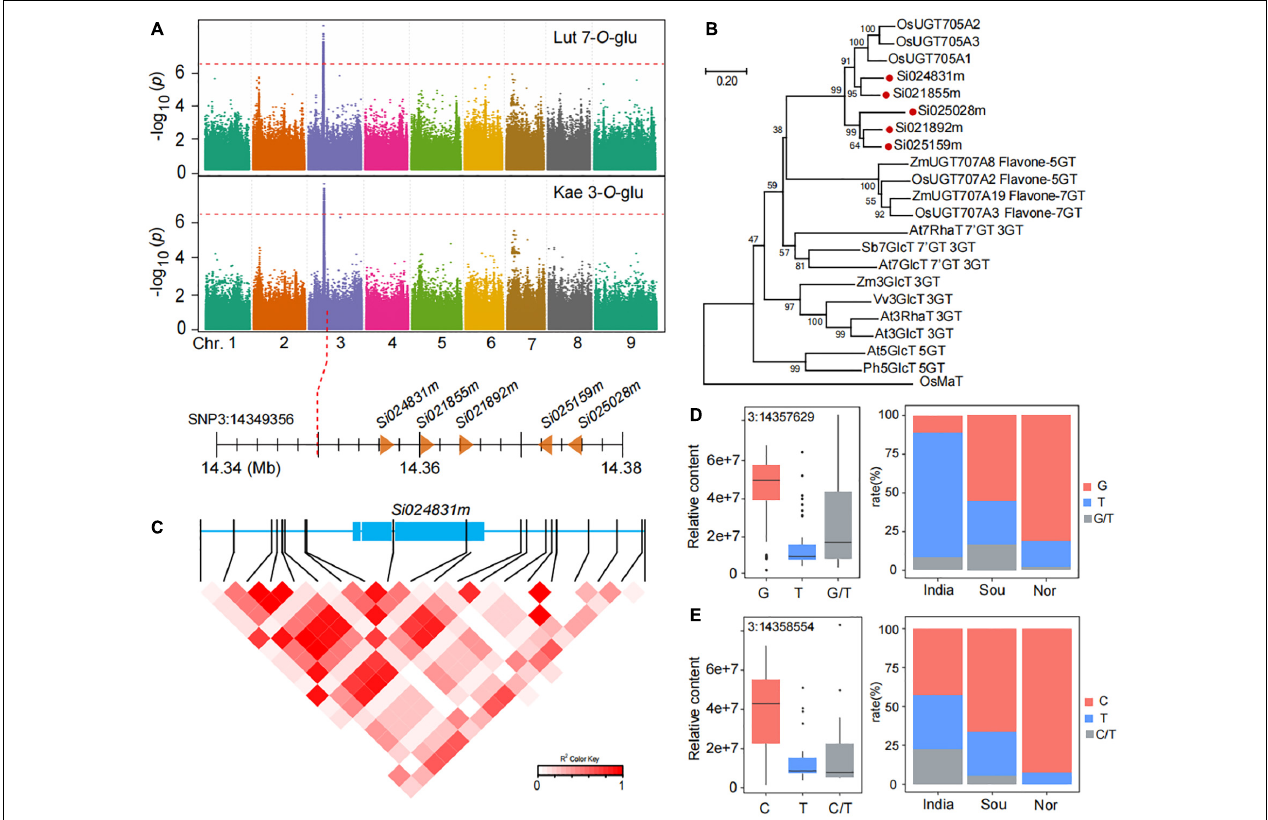
FIGURE 5 | Genome-wide association study of flavone O-glycosides in millet. (A) Manhattan plots of mGWAS results of luteolin 7- O -glucoside (Lut 7- O -Glu), and kaempferol 3- O -glucoside (Kae 3- O -Glu) in millet. The strength of association for the metabolites is indicated as the negative logarithm of the p -value for the LMM model. All metabolite-SNP associations with p -values below 1.8E–06 are plotted against genome location in intervals of 1 Mb. (B) An unrooted phylogenetic tree of the UDP-glycosyltransferase was constructed as described in Methods. Bootstrap values > 70% (based on 1000 replications) are indicated at each node (bar: 0.2 amino acid substitutions per site). (C) A representation of pairwise r 2 values (a measure of LD) among all polymorphic sites in Si024831m , where the color of each box corresponds to the r 2 value according to the legend. (D,E) Natural variation of nucleotide polymorphisms identified in the sequences of Si024831m and their allelic frequencies in millet from India, south of China (Sou), and north of China